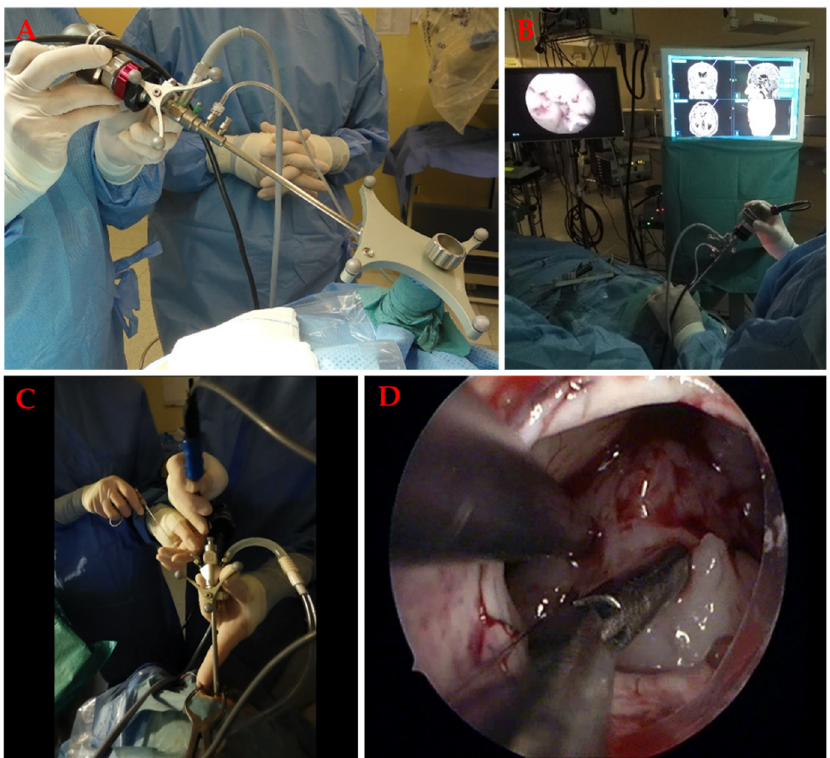
Figure 9. Neuroendoscopy. ( A ) The neuroendocoscope is first navigated. ( B ) During the procedure, the surgical field is observed on the monitor. The exact position of the tip is controlled by a second monitor, which is coupled with the neuronavigation system. ( C ) Full endoscopy with two working channels. ( D ) Endoscopic view during tumour resection.